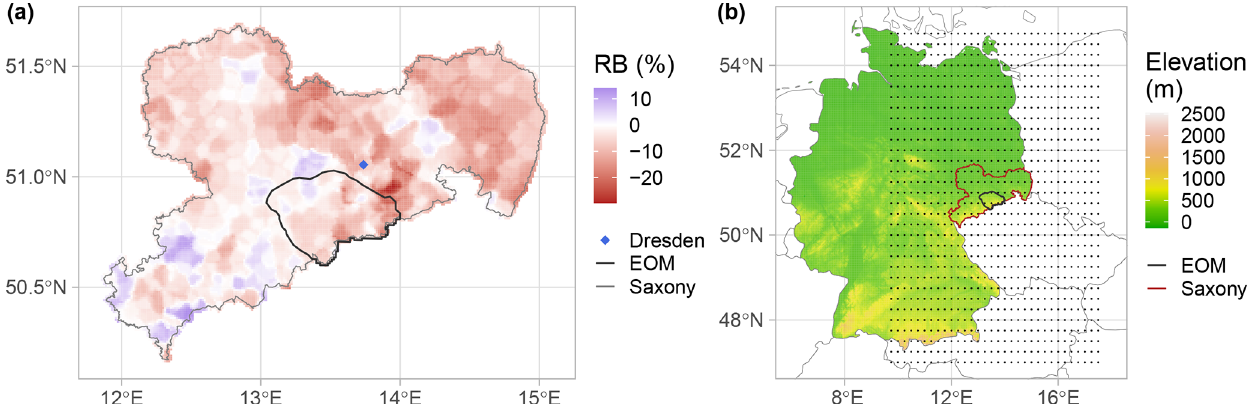
Figure 1. Location of the study region and the predictor’s domain. (a) Relative bias (RB) of precipitation between training and validation periods for the whole ReKIS domain for Saxony. The study region, Eastern Ore Mountains, abbreviated as EOM in the figure, is inside the darker grey line. (b) Topography of Germany, the centre of the ERA5 sub-domain pixels (marked by dots, 32 by 32) used for the predictors and the Eastern Ore